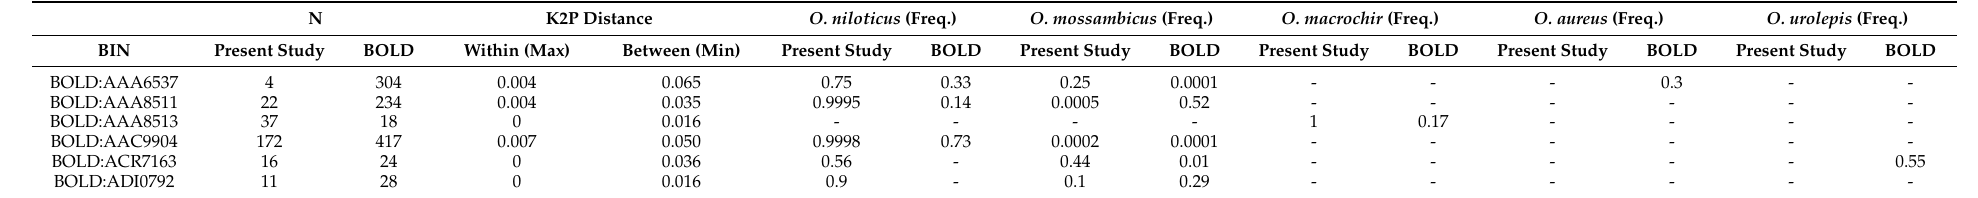
Table 1. Summary of genetic distances and species composition of each MOTUs including their BOLD Barcode Index Number (BIN), number of individuals in present study, number of publicly available records in BOLD (not including newly generated records here), maximum intraspecific and minimum interspecific K2P genetic distances, and relative proportions of species within MOTUs according to the present study and in publicly available BOLD